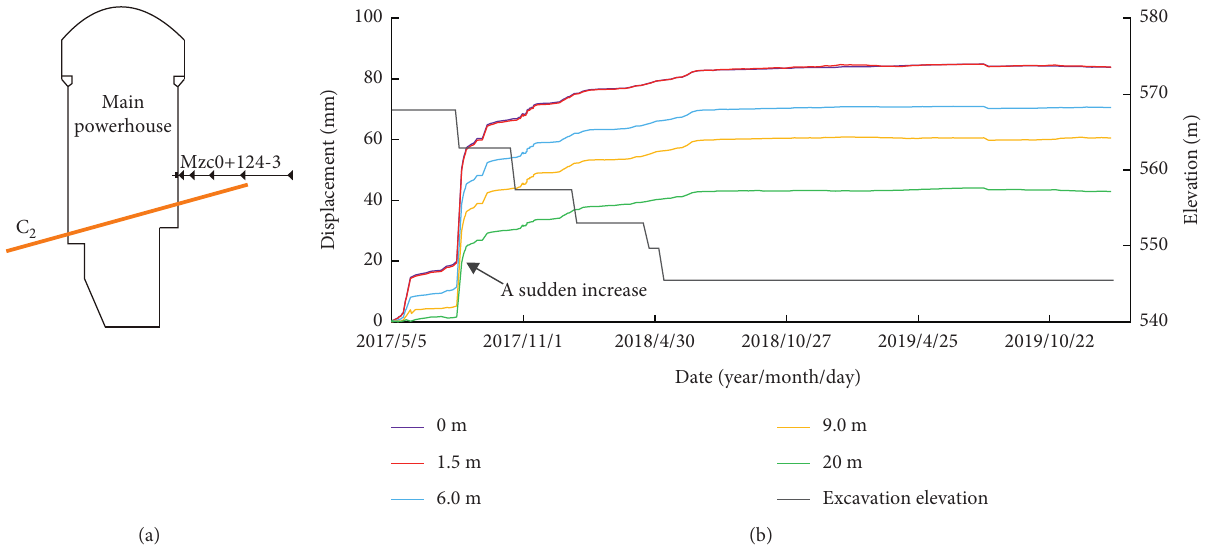
Figure 5: The position schematic diagram of multipoint extensometer and the displacement-time curves: (a) layout of multipoint ex- tensometer M ZC 0 +124-3; (b) the displacement-time curves measured by multipoint extensometer M ZC 0+124-3.